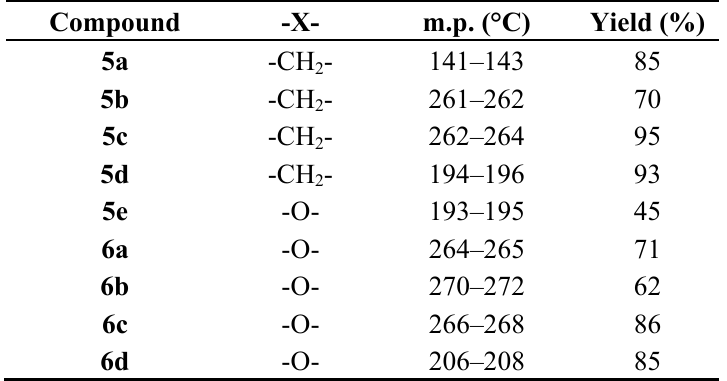
Table 2. Melting points and yields for the piperidine and morpholine derivatives 5a – d , 5e and 6a – d